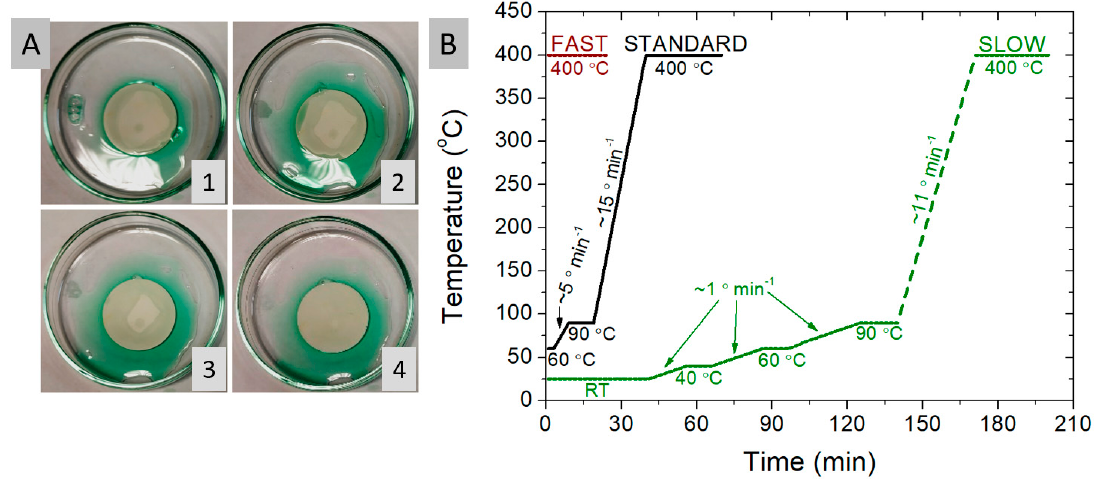
Figure 3. Optical images of the infiltration process of the porous YSZ skeleton ( A , 1–4) and the hot-plate temperature heat treatment profiles evaluated in this work ( B ).